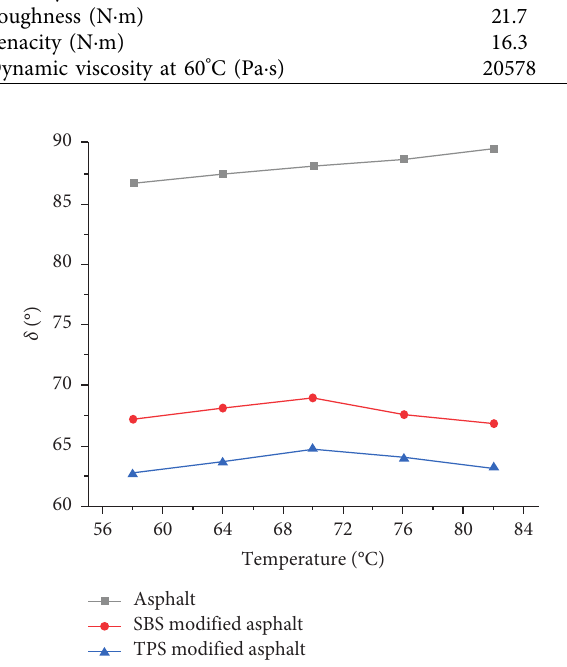
Figure 9: Temperature-phase angle diagram.